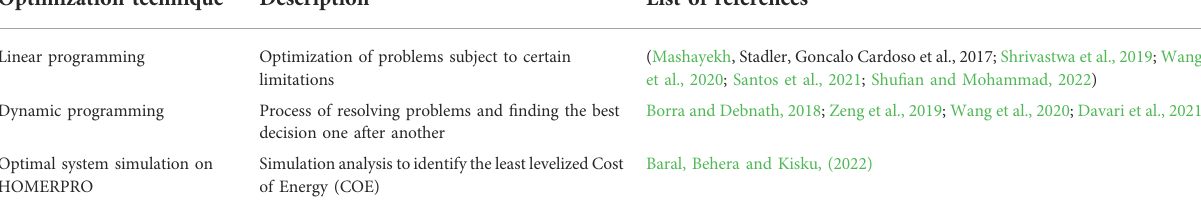
TABLE 7 Optimization techniques reviewed in